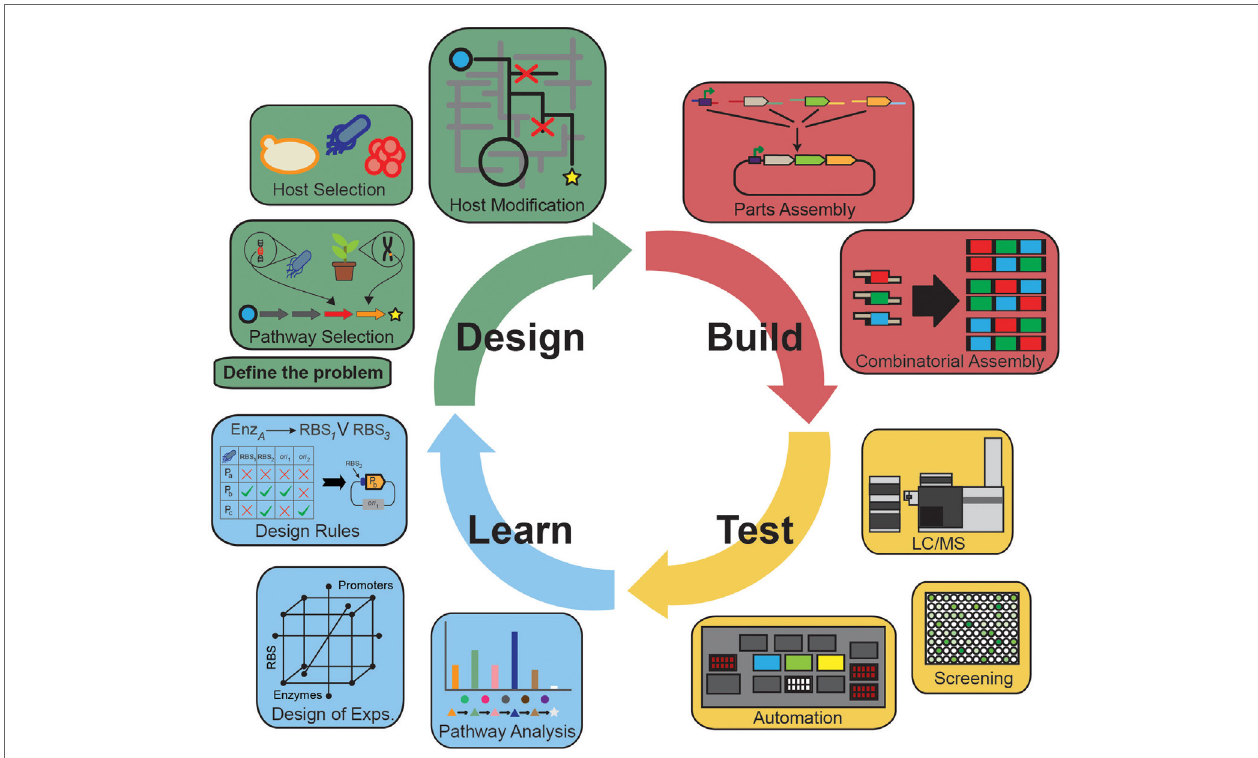
FiGURe 1 | The design–build–test–learn cycle of metabolic engineering highlighting important parts of each of the components . The Design component identifies the problem, selects the desired pathway and host; the Build component selects, synthesizes, and assembles parts for incorporation into the host; the Test component validates the engineered strains for target molecule production, transcripts, proteins, and metabolites; the Learn component analyzes the Test data and informs subsequent iterations of the